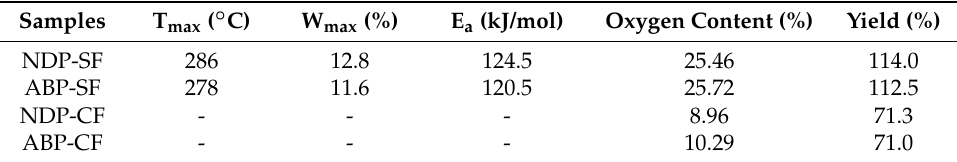
Table 3. Oxidation and carbonization properties of pitch fibers.